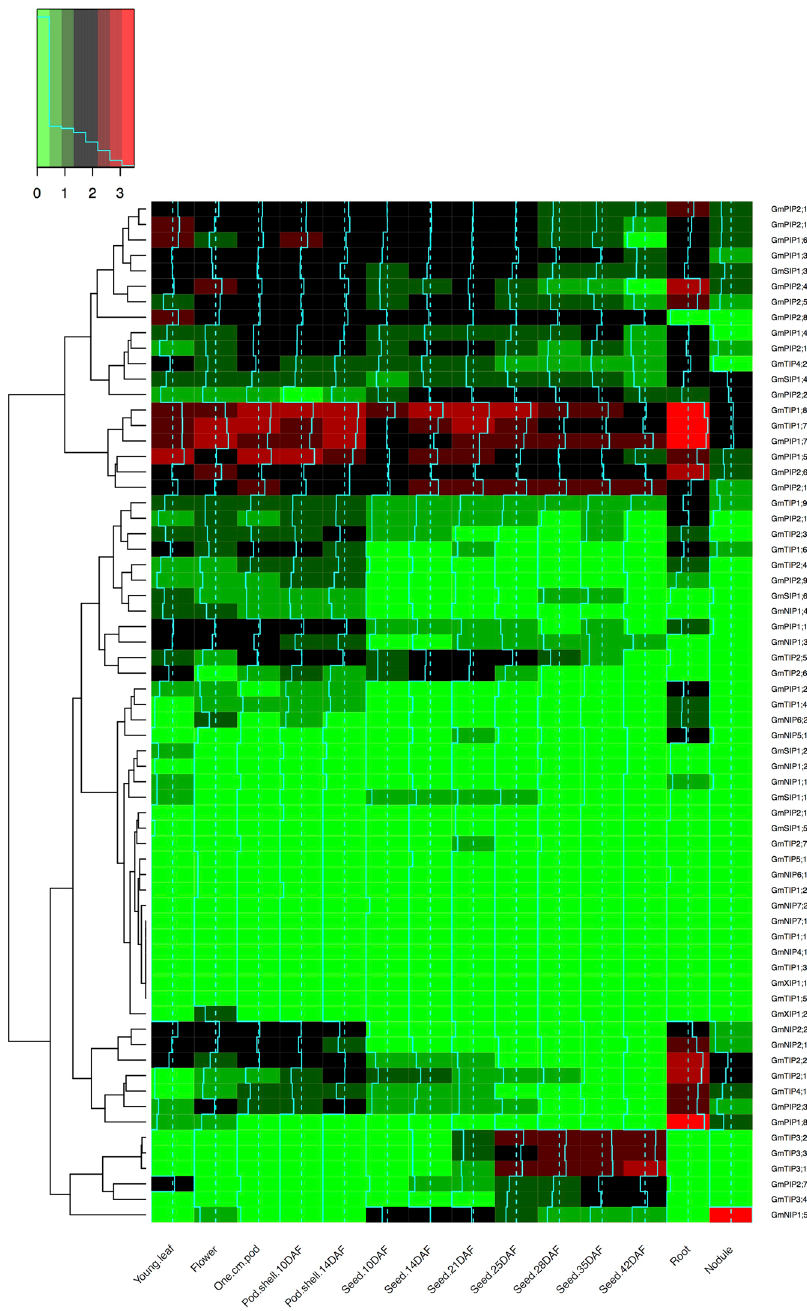
Figure 2. Heatmap profiles of the GmAQPs in tissues. Relative tissue expression levels of GmAQPs based on RNA-seq data were used to construct the expression patterns of soybean genes. The expression data values were plotted as heat map and clustered using R software. The color bar at the top shows the range of expression from lowest expression level (green) to highest expression level (red), black is the median expression